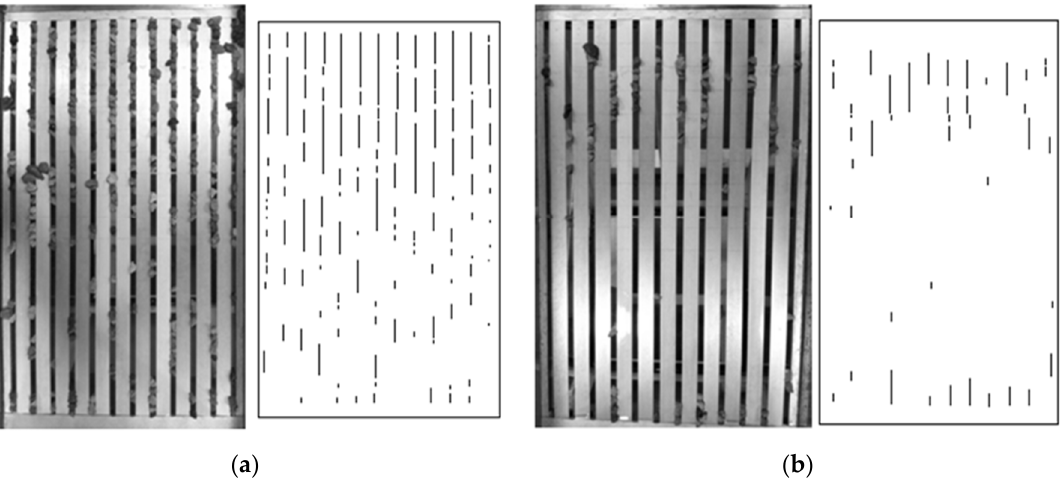
Figure 11. View of racks occlusion at the end of tests for q 1 = 114.6 l/s/m: ( a ) Rack C and horizontal slope; ( b ) Rack C and 30% slope.